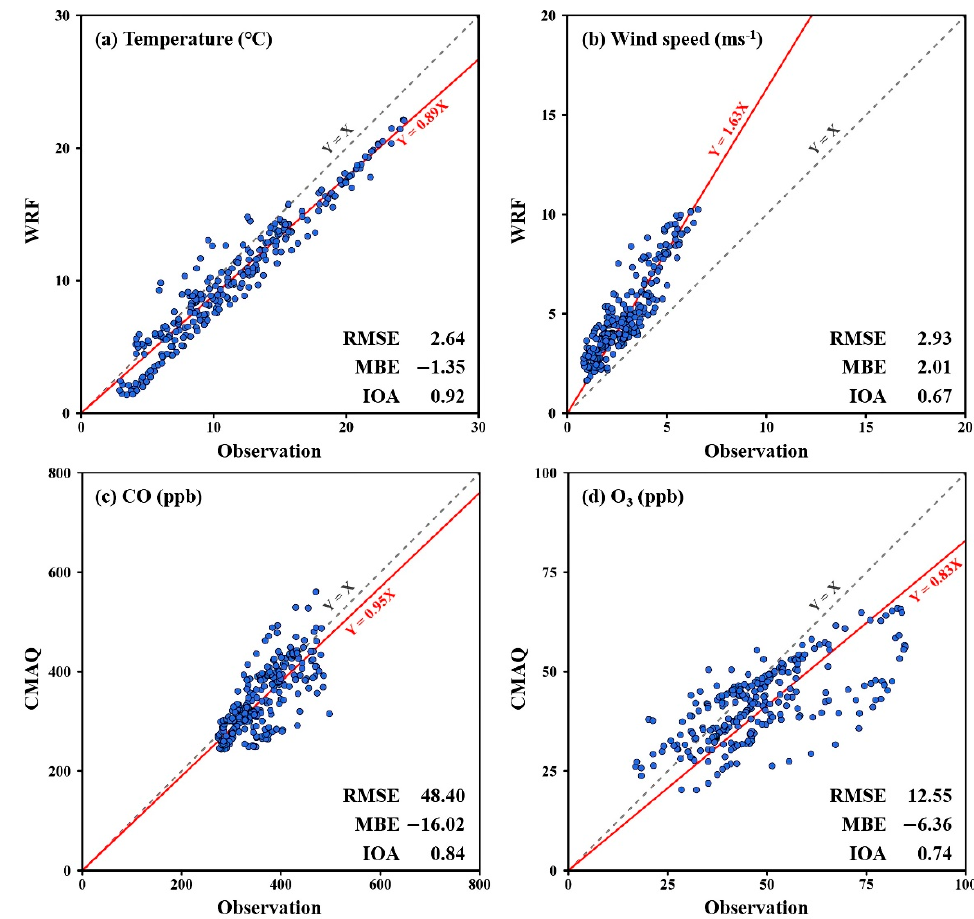
Figure 2. Comparison of WRF and CMAQ numerical simulation results with observations of ( a ) temperature, ( b ) wind speed, ( c ) CO, and ( d ) O 3 in D02 from 20 to 30 April 2020 .